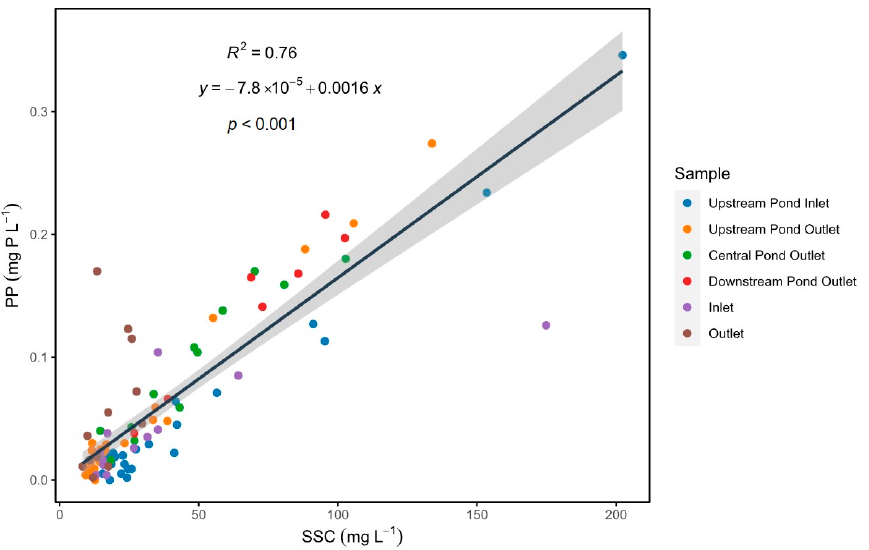
Figure 10. Linear regression of SSC (mg L − 1 ) and PP (mg P L − 1 ) from Pond Inlet/Outlet sampling sites during a storm event on the 12th and 13th March 2019, and near baseflow from the Inlet and Outlet ( n = 96). The grey band represents 95% confidence intervals.